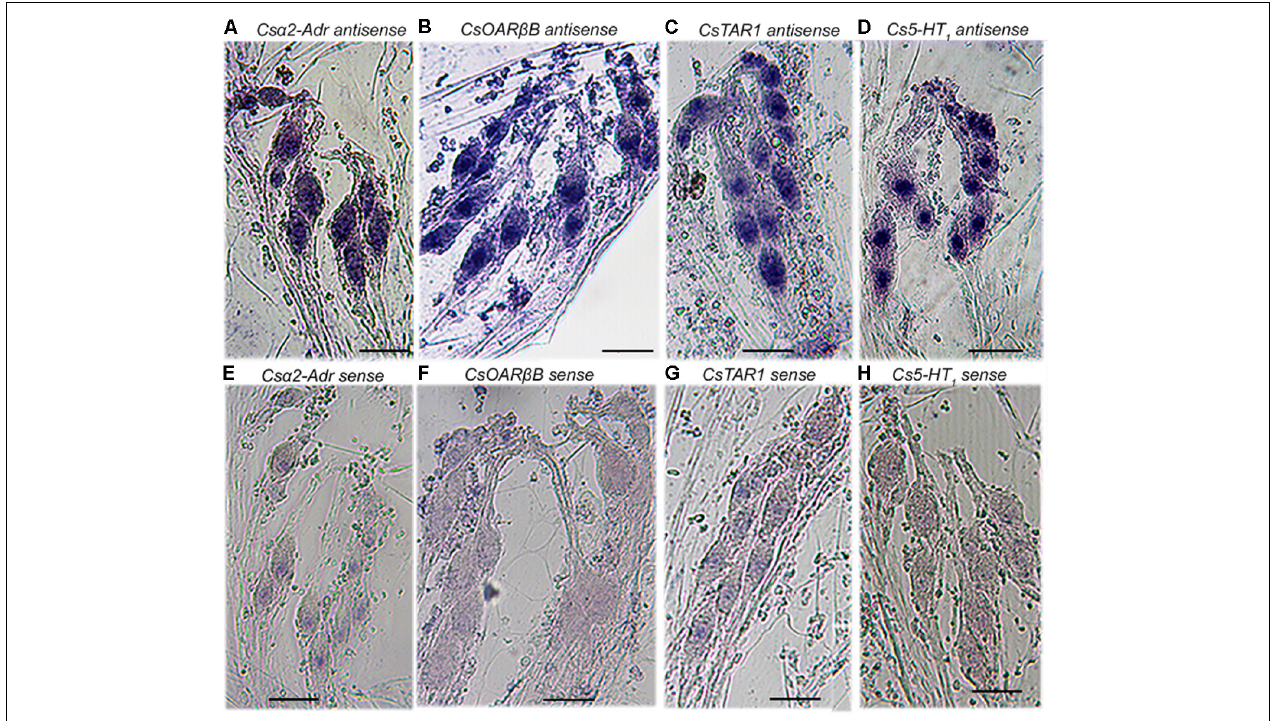
FIGURE 3 | Expression of four putative biogenic amine receptors in the mechanosensory neurons of VS-3 slit sensilla. Whole-mount in situ hybridization of the patellar hypodermis using digoxigenin labeled antisense and sense (control) probes. Antisense RNA probes for putative Cs α 2-Adrenergic (A) , CsOAR β B (B) , CsTAR1 (C) , and Cs5-HT 1 (D) , receptors produced strong signals in VS-3 neurons, while the sense probes for the same genes did not (E–H) . Scale bars 50 µ m in all